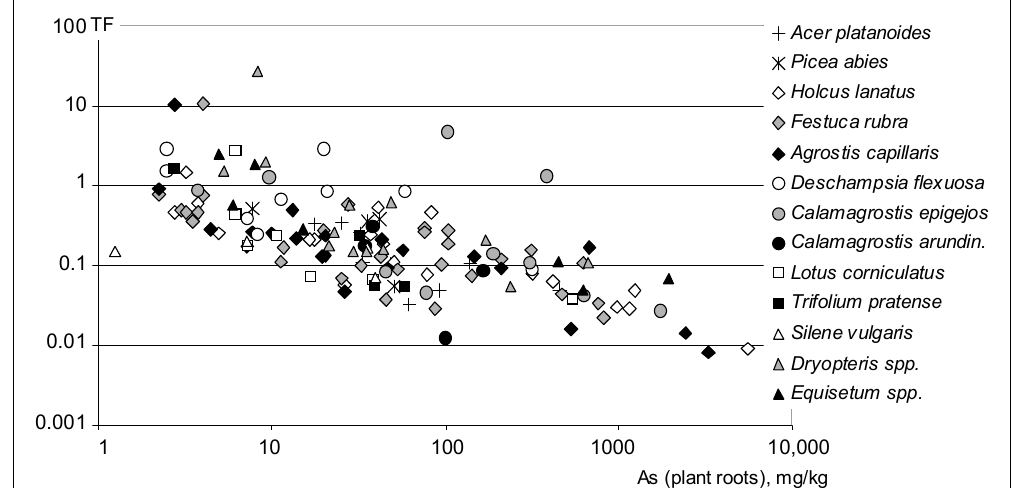
Figure 4. Roots to shoots transfer factor of arsenic (TF) as related to root As concentrations. Calculated correlation coe ffi cient: R = − 0.693, signi fi cant at p < 0.001.